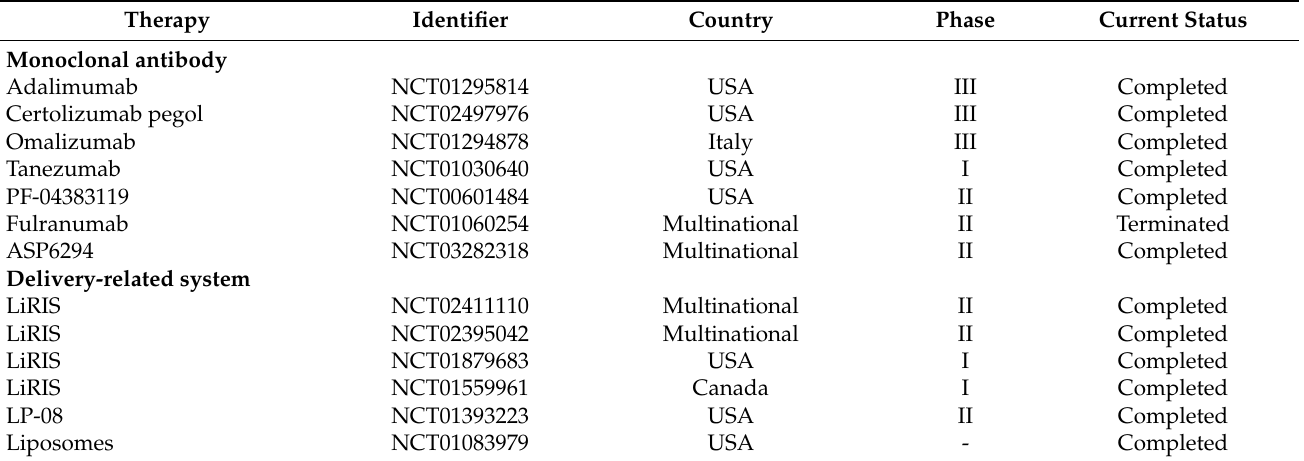
Table 2. The ongoing clinical studies on the treatment of